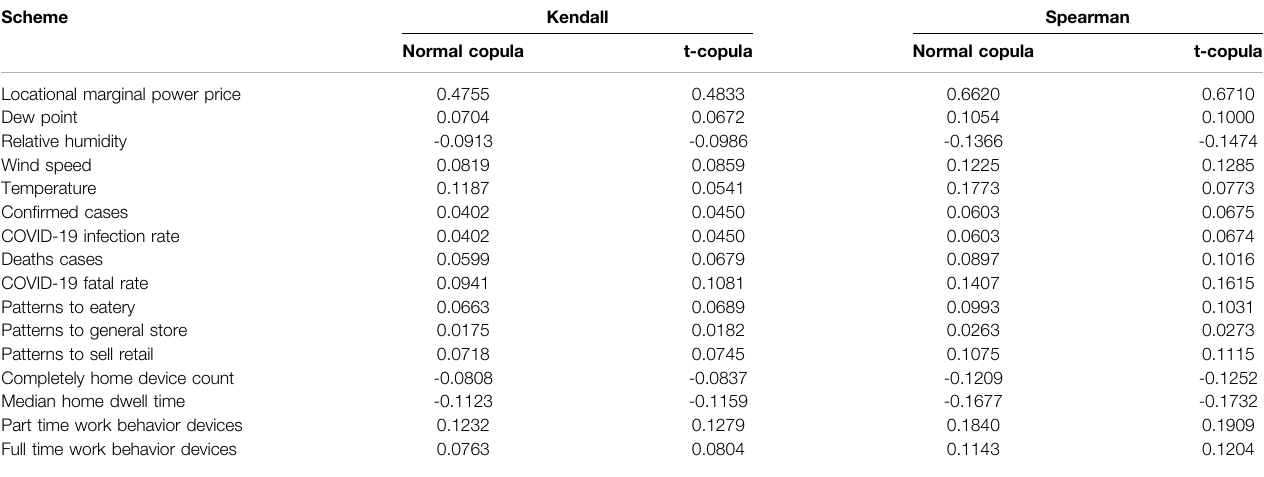
TABLE 1 | Correlation analysis between in fl uencing factors and power load during